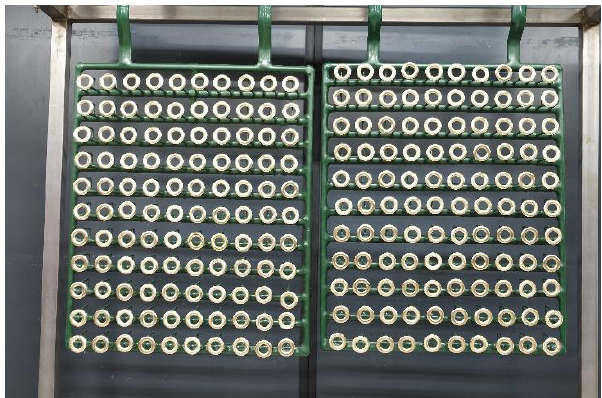
Figure 2. Galvanic frame with items placed in a fixed position.